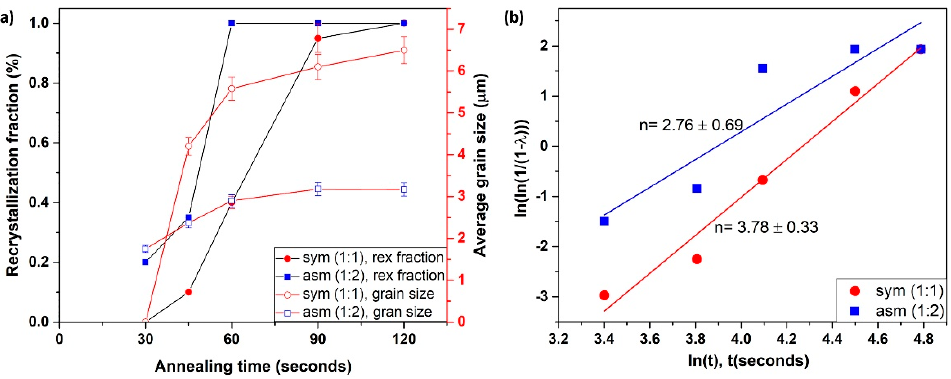
Figure 15. Recrystallization kinetics for symmetric and asymmetric rolling. ( a ) Fraction of recrystallization and average grain size, ( b ) JMAK (Johnson–Mehl–Avrami–Kolmogorov) exponent.